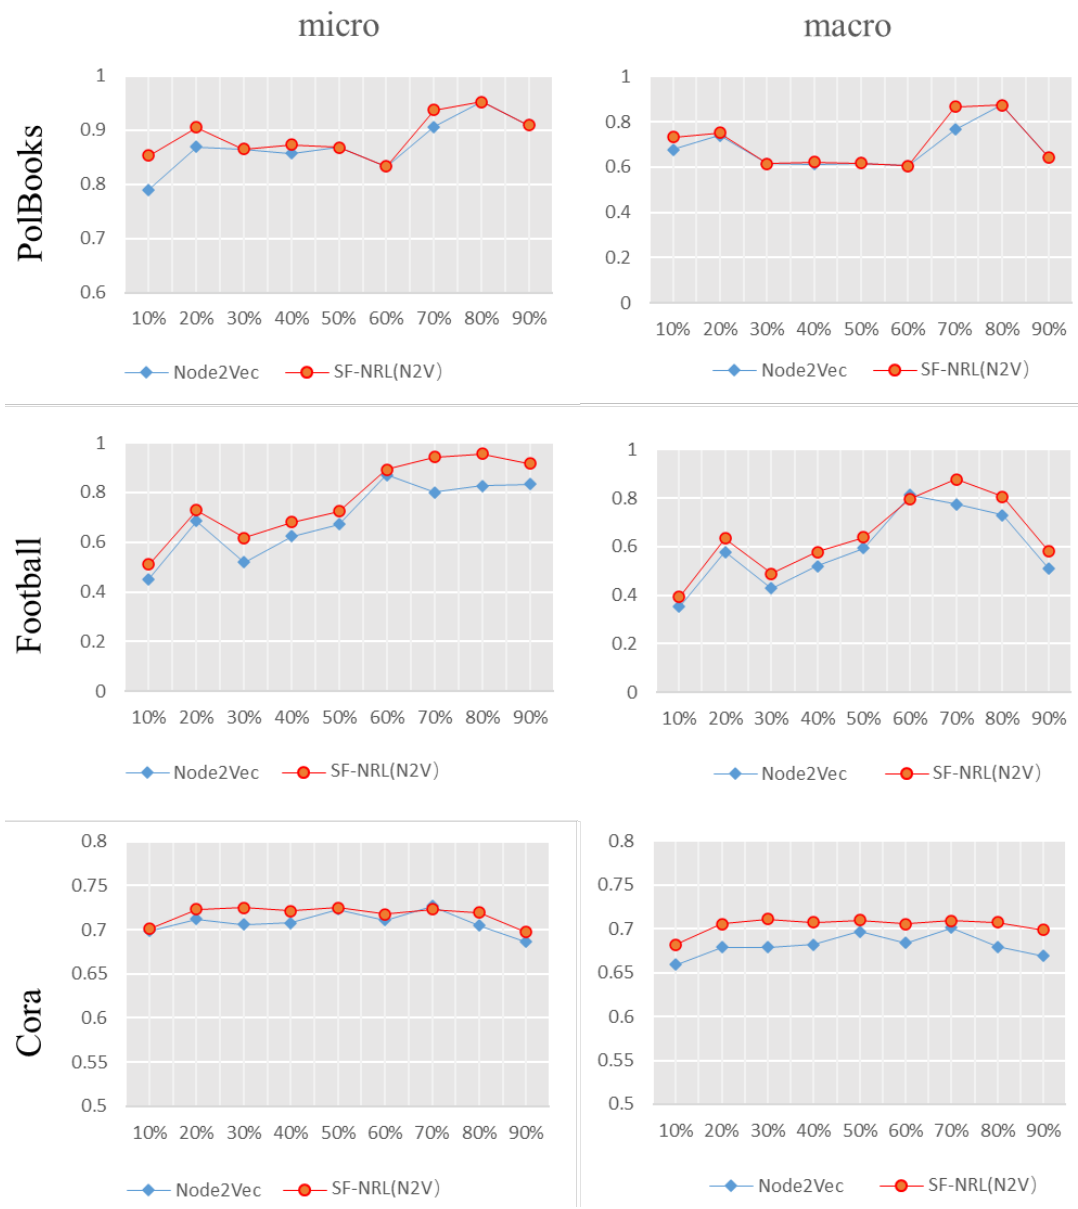
Figure 7. Comparison of F 1 value of the multi-label classification experiment results. The red polyline is the F 1 value of SF-NRL(N2V) and the blue one is that of Node2Vec. Similarly, Figure 8 depicts the comparison between SF-NRL(LINE) and LINE; the left side is Micro-F1 value. From top to bottom, the results on datasets of PolBooks, Football, and CORA are, respectively, shown where the red polyline represents SF-NRL(LINE) and the blue one indicates LINE. In this group of experiments, compared with the NMI value in the community discovery experiment, SF-NRL(LINE) has been greatly improved, and it still performs well in the multi-label classification task. Compared with the comparative algorithm LINE, SF-NRL(LINE) obtains greater improvement in both Micro-F1 and Macro-F1 values.